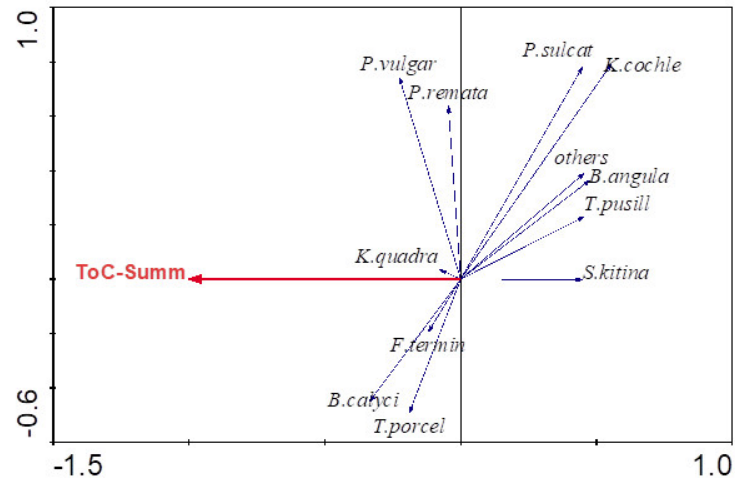
Figure 5. The redundancy analysis (RDA) map of major group of dominant rotifers and temperature mean for summer—ToC-Summ. Labels of rotifer species: K. quadra — Keratella quadrata; K. cochle — K. cochlearis; T. pusill — Trichocerca pusilla; T. porcel — T. porcellus; S.kitina — Synchaeta kitina; F. termin